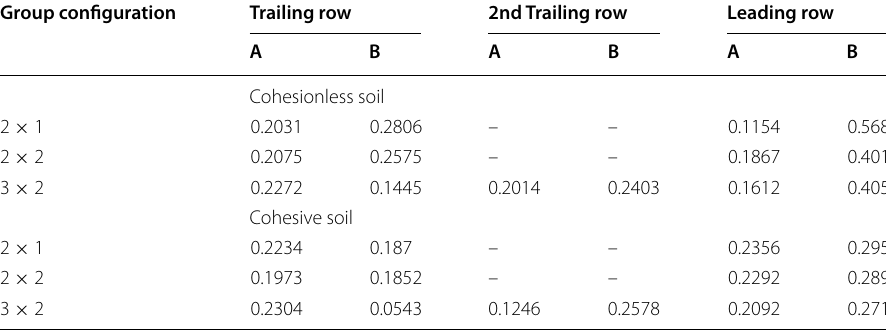
Table 2 Values of A and B constants for both cohesionless and cohesive soil Group configuration Trailing row 2nd Trailing